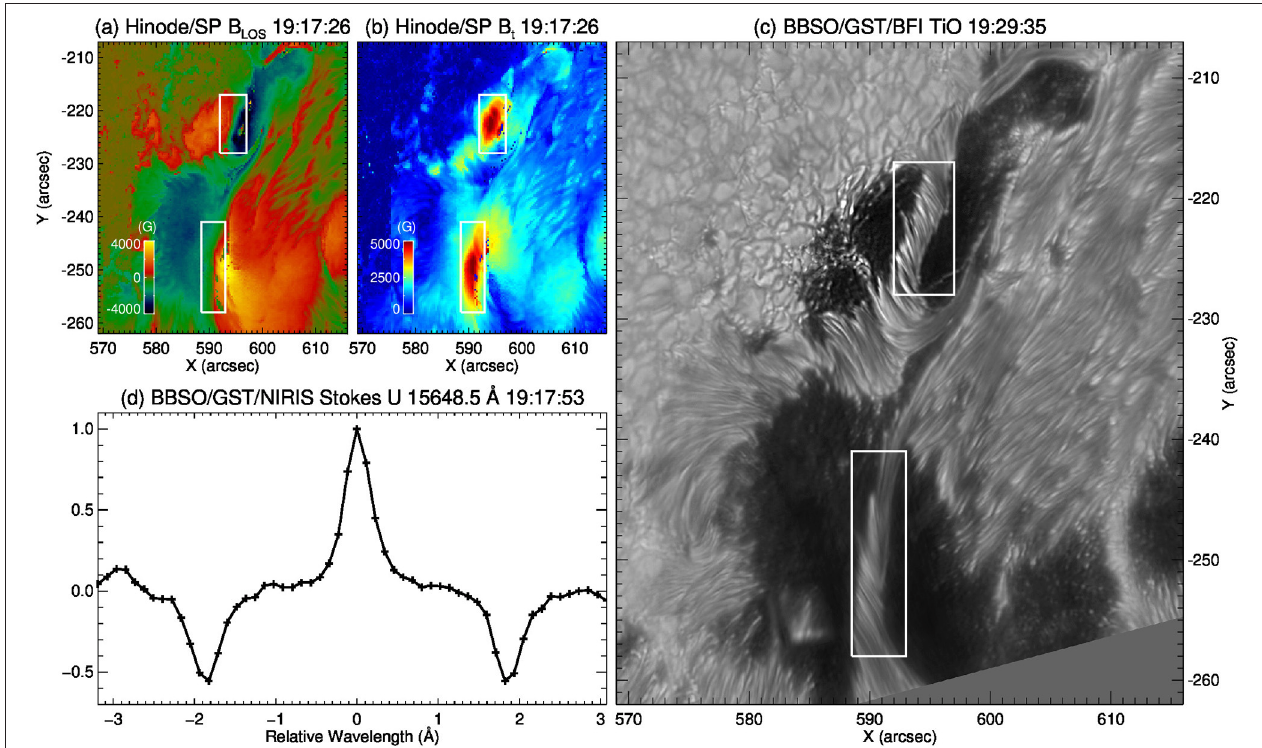
FIGURE 5 | Unusual structures of NOAA AR 12673 on 2017 September 6 as revealed in Hinode line of sight (a) and transverse (b) magnetic field maps and BBSO/GST TiO image (c) . The white boxes mark the two strong transverse field regions along the PIL, where photospheric signatures of twisted flux ropes are present. Panel (d) shows the Stokes U profile of a selected pixel with strong transverse field in the upper box measured by BBSO/GST’s NIRIS. A field strength of 5570 G is obtained by the direct measurement of Zeeman splitting (Wang et al., 2018b). Reproduced by permission of AAS.